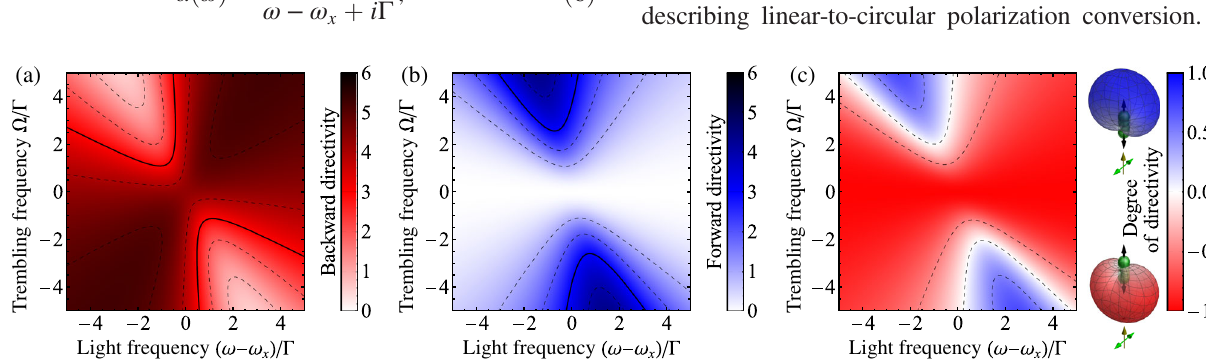
FIG. 4. (a) Backward and (b) forward directivity of nonpolarized light inelastically scattered by a trembling resonant particle depending on the incident light frequency ω and trembling frequency Ω . Solid line shows the directivity equal to 3 that limits usual Kerker effect. (c) Degree of directivity ½ D ð n 0 Þ − D ð − n 0 Þ(cid:3) = ½ D ð n 0 Þ þ D ð − n 0 Þ(cid:3)